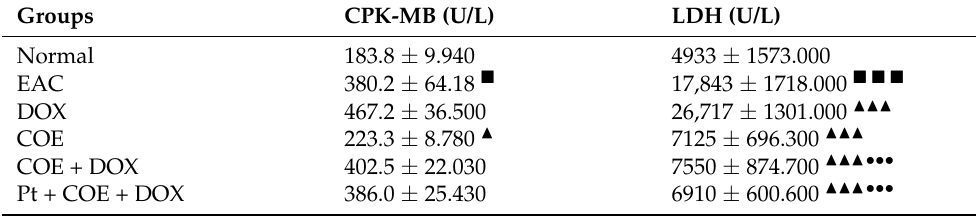
Table 3. Effect of COE on CPK-MB and